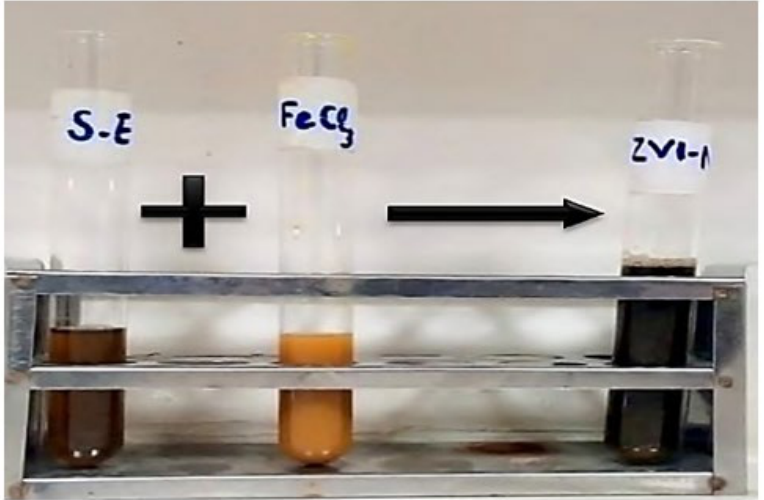
Figure 2. Observable color change of FeCl 3 precursor from orange color to black color by the addition of Nigella sativa seed extract indicating the synthesis of ZVI - NPs.